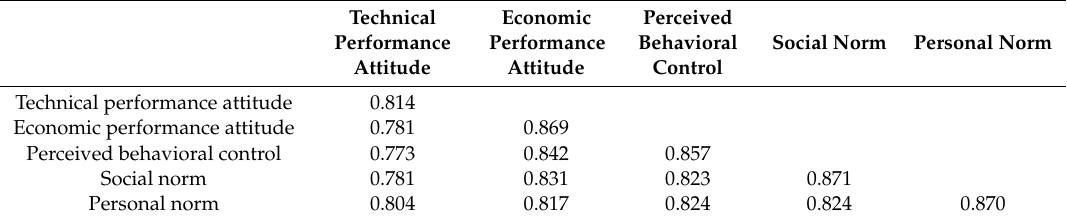
Table 6. Assessment of measurement model: discriminant validity.